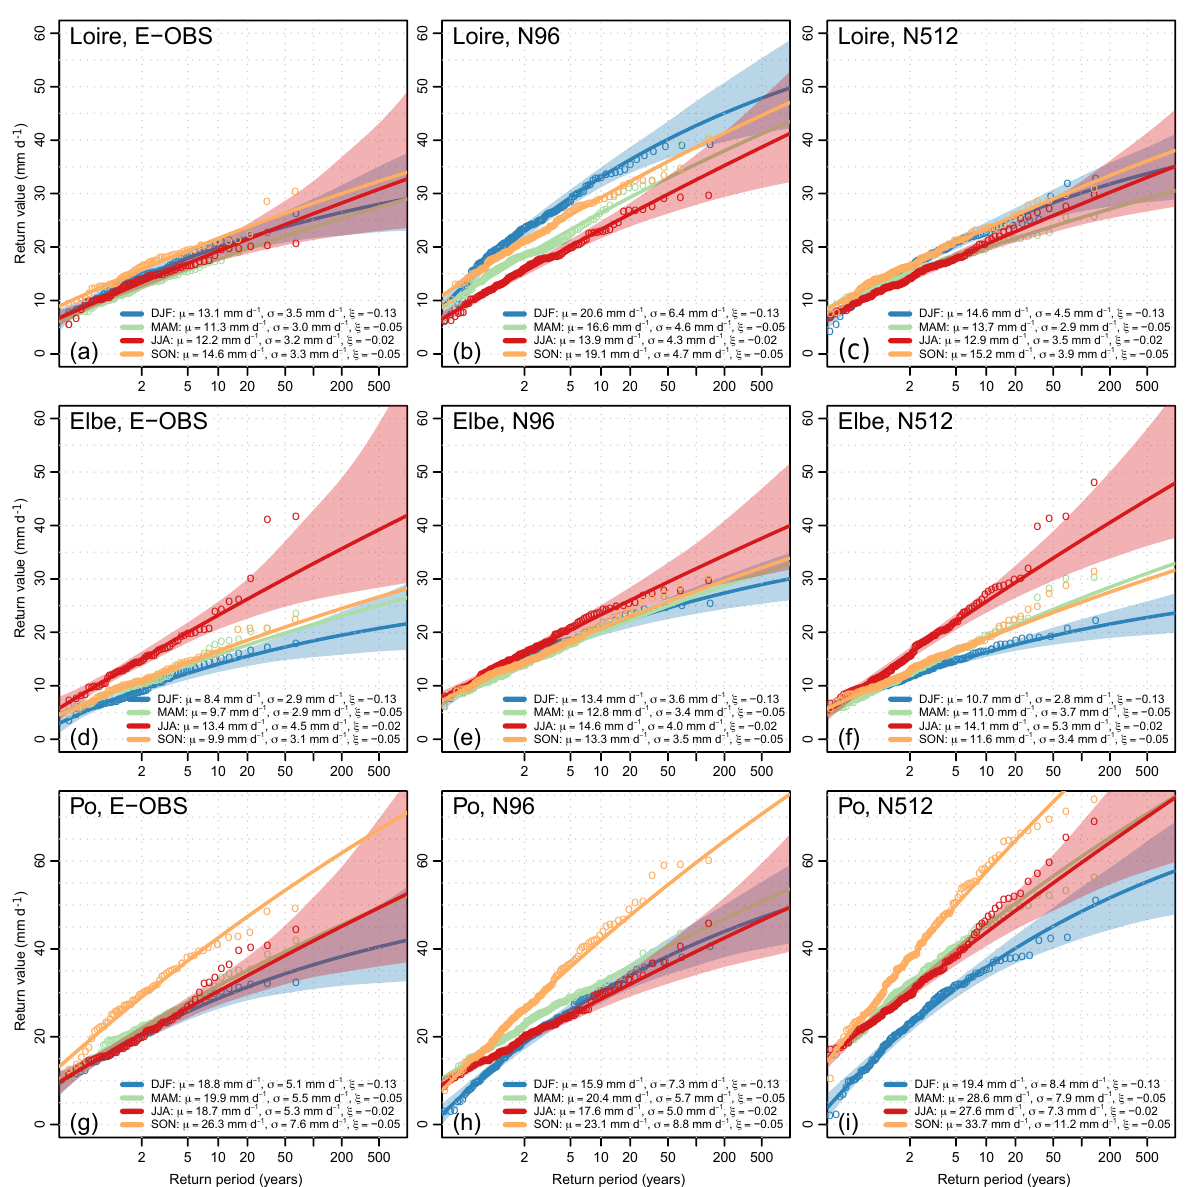
Figure 4. Fitted GEV distributions for (a–c) Loire, (d–f) Elbe, and (g–i) Po river basins, and for (a, d, g) E-OBS observed precipitation, (b, e, h) the N96 model, and (c, f, i) the N512 model. 95% resampling confidence intervals are shown as shaded areas for winter (DJF) and summer (JJA). Block maxima (circles) are shown at return periods m + 1 , where m is the number of these maxima, i.e. here the number m + 1 − i of years × ensemble members, and i = 1 ,...,m is their rank. Results for N216 are generally between those for N96 and N512 (not shown). The three basins are indicated in Fig. 5a and